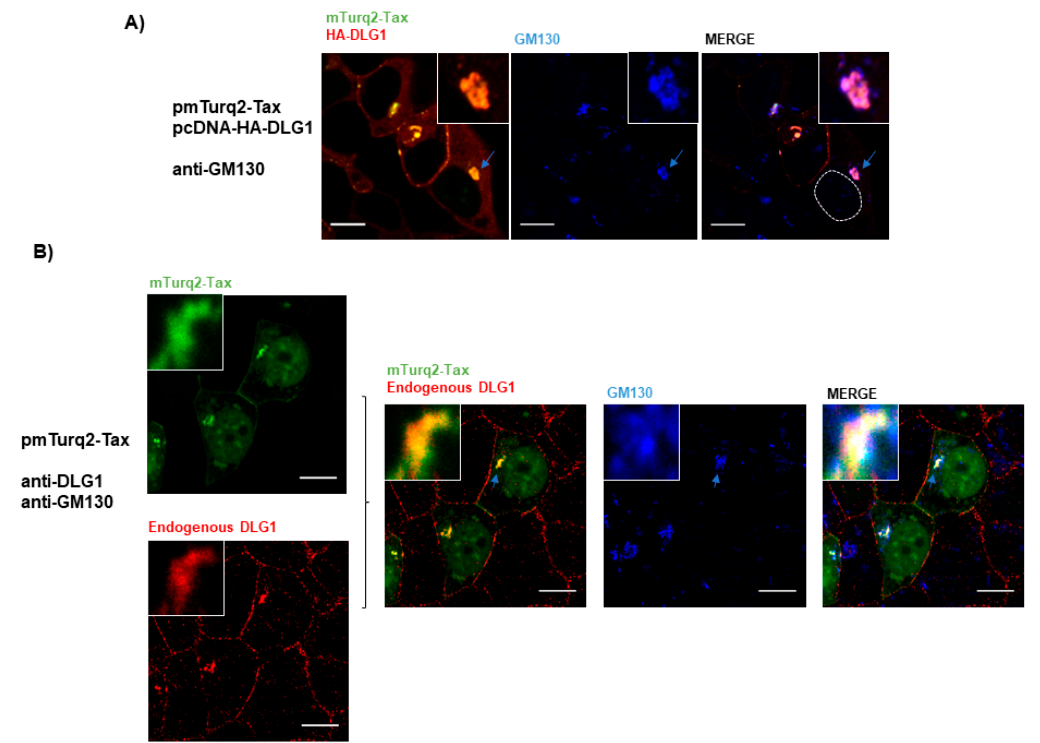
Figure 5. The DLG1-Tax complexes co-distribute with the Golgi apparatus. ( A ) Evaluation of co-localization of the perinuclear DLG1-Tax complexes with GM130 in overexpression experiments. HEK293 cells transiently transfected with pcDNA-HA-DLG1 and pmTurq2-Tax plasmids were immunostained to detect GM130 expression using a monoclonal anti-GM130 antibody (blue). HA-DLG1 expression was detected using an anti-HA antibody (red) and mTurq2-Tax expression was observed directly through the mTurq2 emission (green). Dashed circles indicate nuclear regions. The DLG1-Tax complexes are shown in yellow; ( B ) Analysis of co-localization of the endogenous DLG1-Tax complexes with GM130. HEK293 cells were transiently transfected with mTurq2-Tax (green), and endogenous DLG1 (red) and GM130 (Blue) were detected using specific antibodies. In ( A , B ), the light blue arrow indicates the region which is amplified in the inset, indicating the DLG1-Tax-GM130 triple co-distribution. All scale bars are 10 µm.